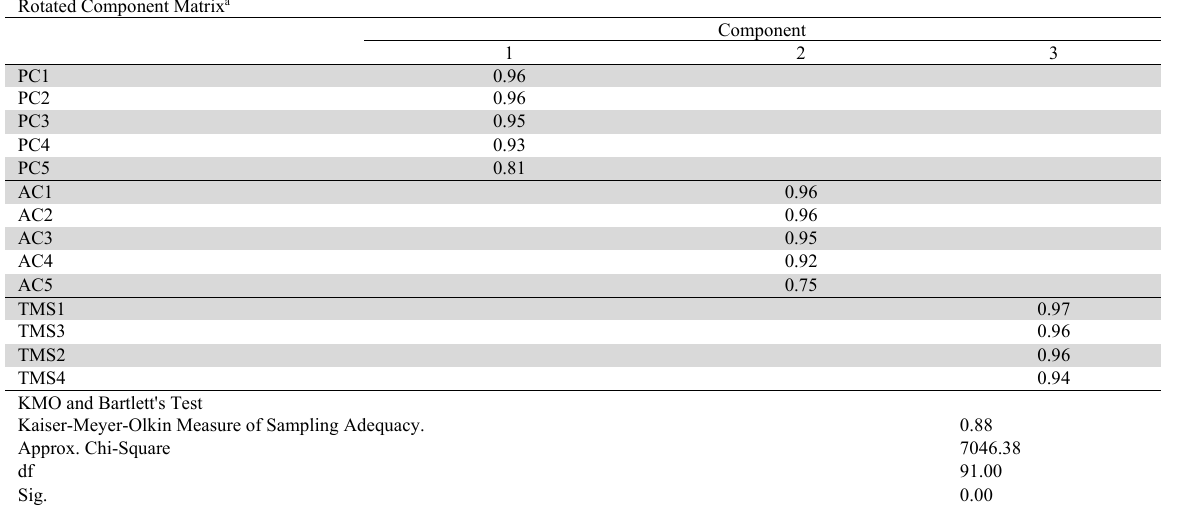
Factor Analysis Rotated Component Matrix